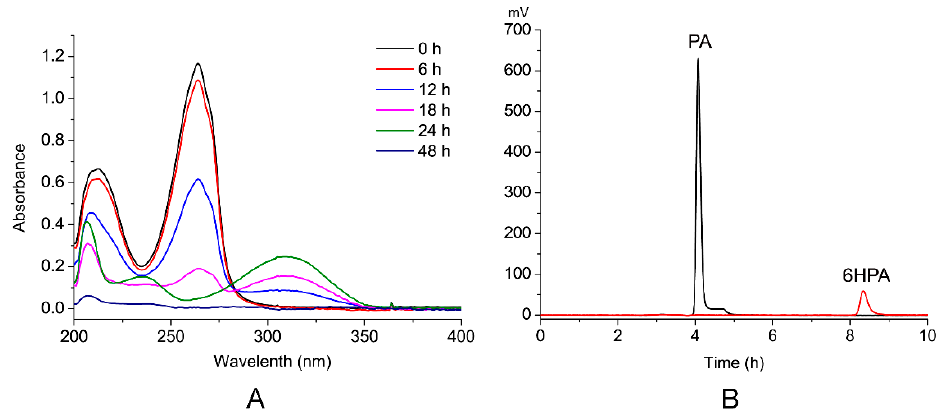
Figure 4 . PA degradation analysis by the strain PA18 using UV-VIS and high-performance liquid chromatography (HPLC). ( A ) The UV-VIS absorption of each compound during PA degradation from 200 to 400 nm. ( B ) HPLC analysis of the conversion of PA into 6HPA at 12 h. The black line indicates the sample collected at 0 h and the red line indicates at 12 h.